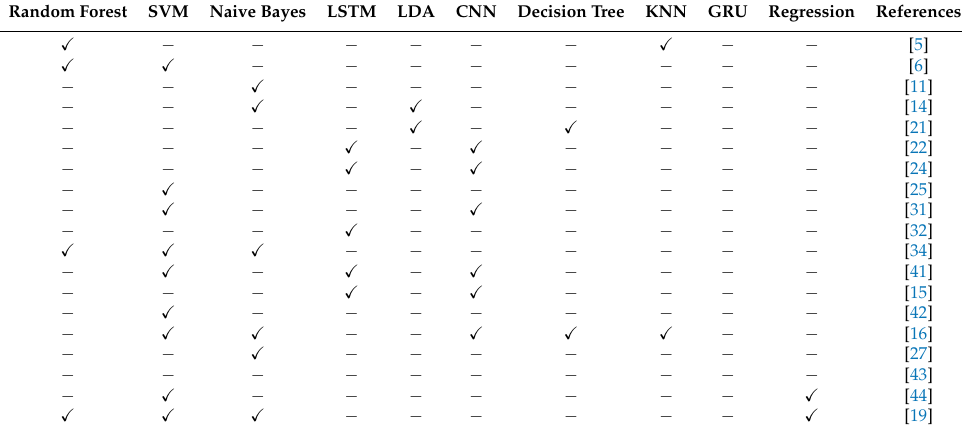
Table 2. Different machine learning techniques used in the